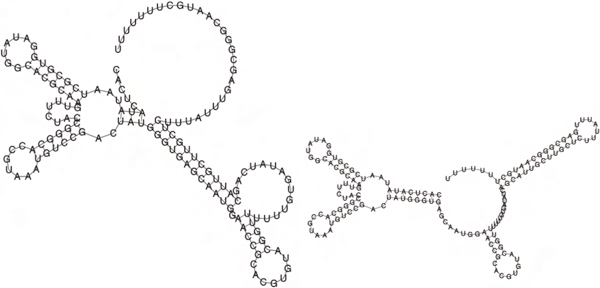
GENE ON (left) and GENE OFF (right) secondary structures for the 148 nt. XPT guanine riboswitch from B. subtilis with sequence CACUCAUAUA AUCGCGUGGA UAUGGCACGC AAGUUUCUAC CGGGCACCGU AAAUGUCCGA CUAUGGGUGA GCAAUGGAAC CGCACGUGUA CGGUUUUUUG UGAUAUCAGC AUUGCUUGCU CUUUAUUUGA GCGGGCAAUG CUUUUUUU. Sequence and secondary structure taken from [35]. The free energy of GENE ON resp. GENE OFF secondary structrure is -16.46 kcal/mol resp. -22.6 kcal/mol. Free energies were determined using RNAeval and figures produced using RNAplot, both from the Vienna RNA Package [40].